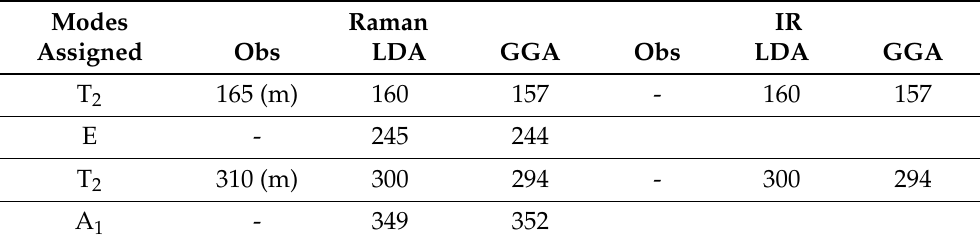
Figure 3. Ambient pressure Raman spectrum of LiInCr 4 O 8 , together with the fitting curve. Shown also are the theoretical mode frequencies (GGA) and the Raman mode frequencies for Cr 2 O 3 [23,24]. Table 3. Mode assignment and comparison of experimental and theoretical mode frequencies (in cm − 1 ). (w), (m), and (s) denote the strength of active mode, viz., weak, medium and strong,